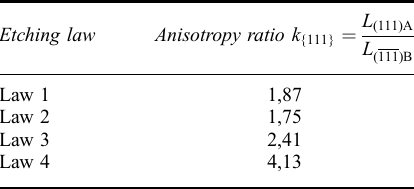
TABLE III Anisotropy Ratio for the Various Etching